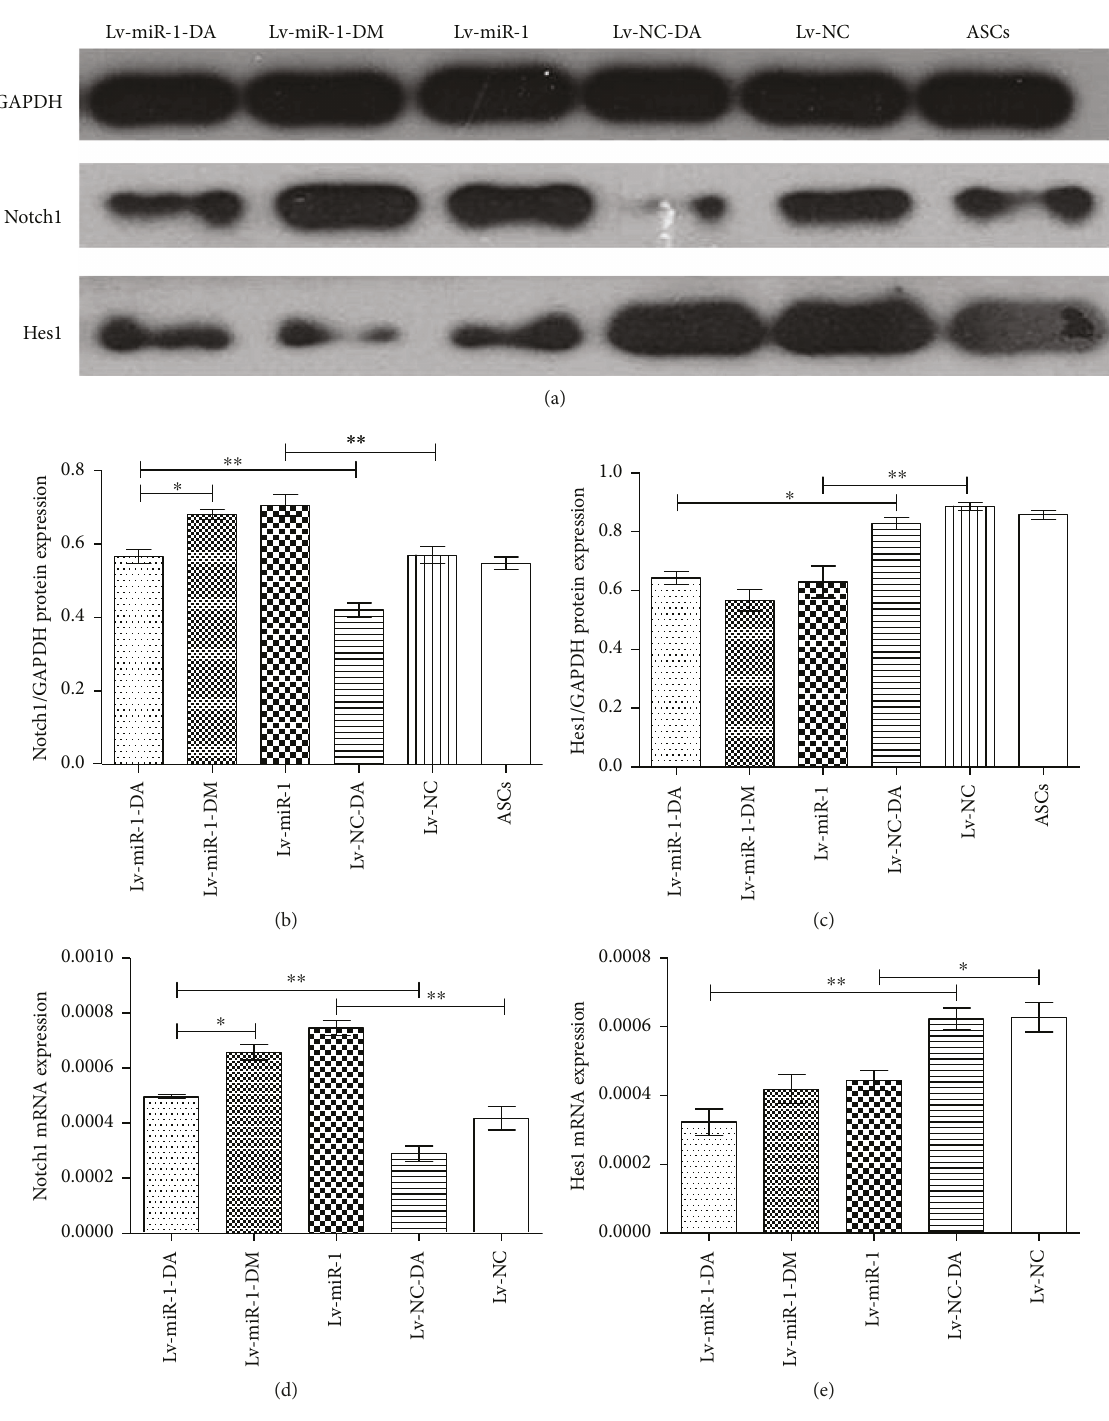
Figure 4: Notch1 and Hes1 protein and gene expression levels in miRNA-1-expressing ASCs after DAPT treatment. ASCs infected with miRNA-1-expressing lentivirus were treated for 7 days with DAPT (Lv-miR-1-DA) or DMSO (Lv-miR-1-DM) or untreated (Lv-miR-1). ASCs infected with control lentivirus were treated for 7 days with DAPT (Lv-NC-DA) or untreated (Lv-NC). Uninfected ASCs were used as negative control. (a) Western blot results of Notch1 and Hes1 protein expression. GAPDH was used as normalization control. (b and c) Quanti fi cation of the relative expression level of each protein compared with the control. ∗ and ∗∗ as determined by one-way ANOVA. (d and e) Notch1 and Hes1 mRNA levels compared with control. ∗ and ∗∗ as determined by one-way